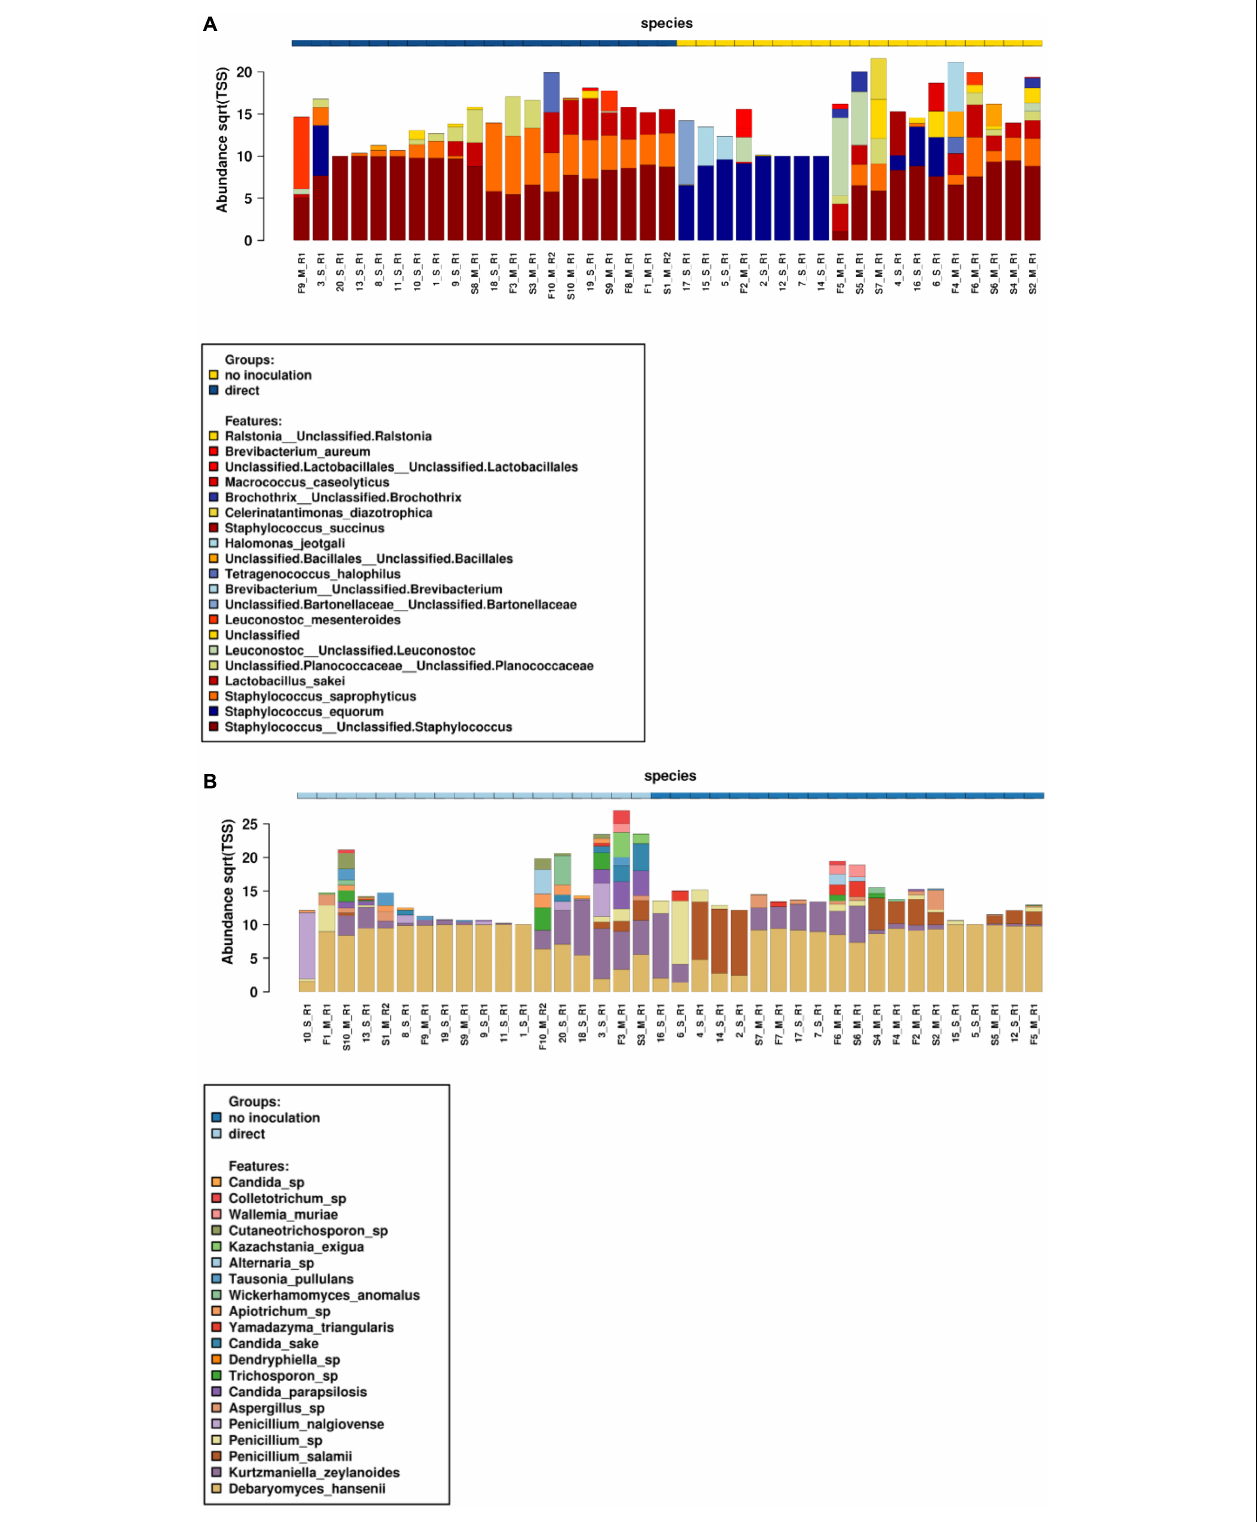
FIGURE 2 | Relative abundances of bacterial (A) and fungal (B) communities at the start and end of conservation for both meat and casing samples. S, start date meat samples (indicated as S1–S10); F, finish date meat samples (indicated as F1 to F10); 1–10, start date for surface casing samples; 11–20, finish date for surface casing samples; M, meat; S, sausage casing; R,